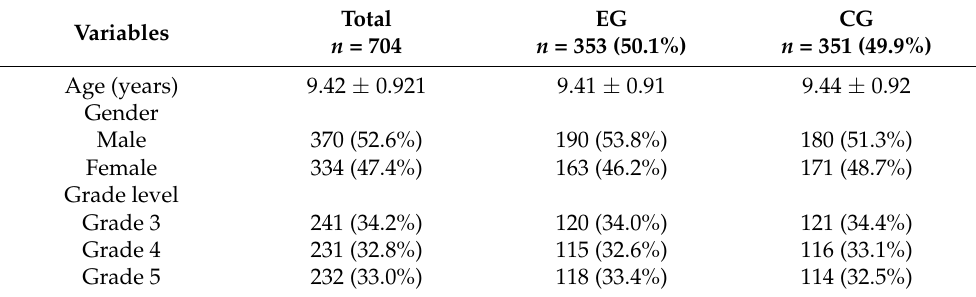
Table 1. General Characteristics (Mean, Standard Deviation and Frequency) of the Participants. Total Variables n = 704